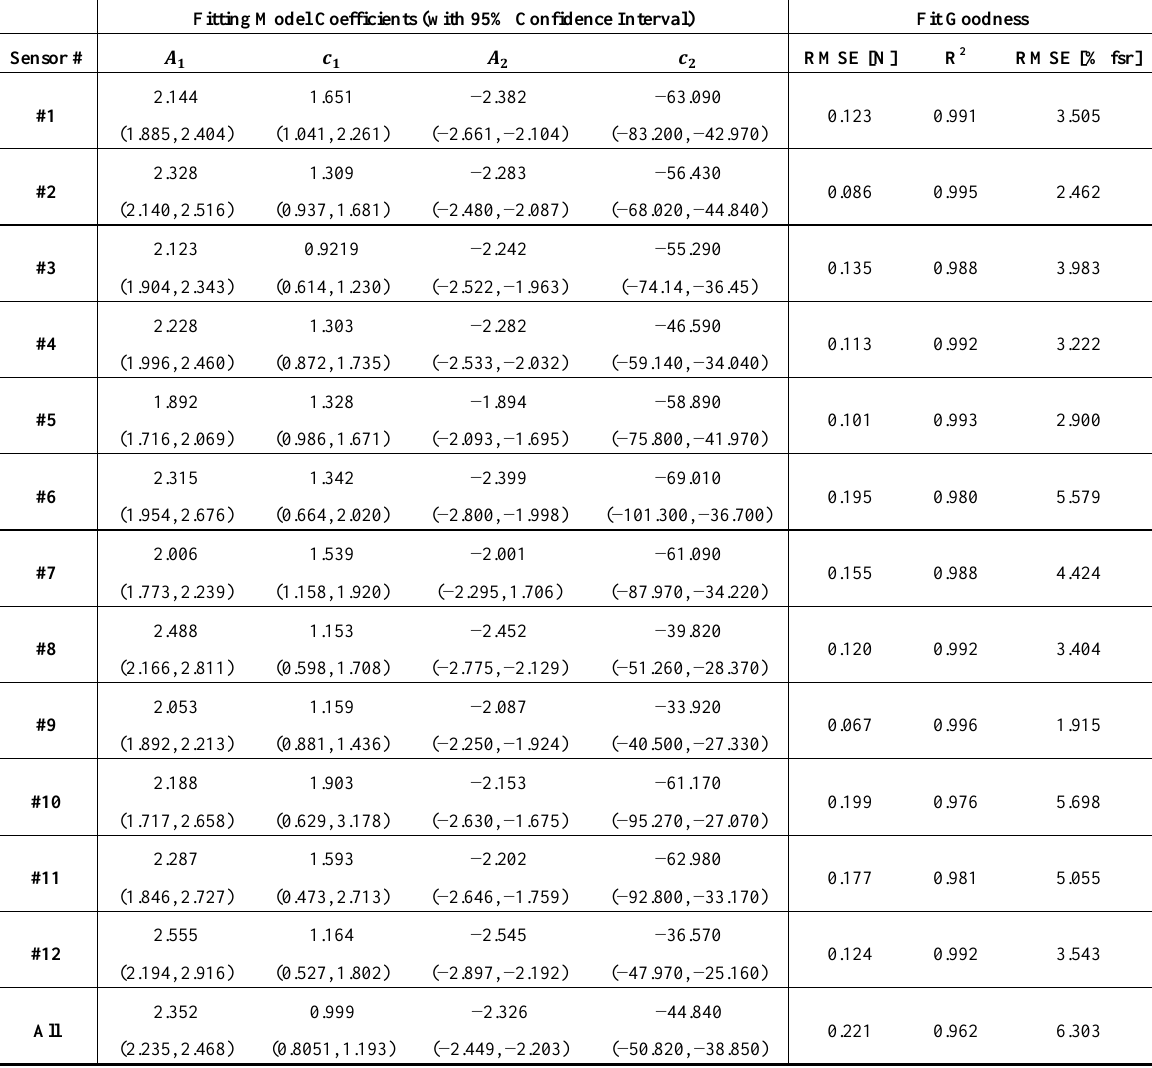
Table 1. Fitted model of the force-to-output voltage